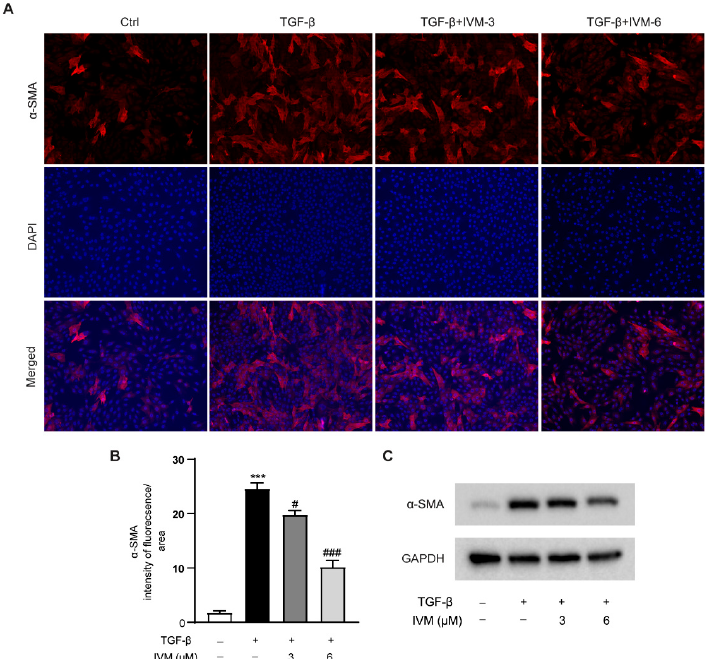
Figure 7. Effects of ivermectin on TGF- β 1-induced HSC activation: ( A ) IHC staining of α -SMA in CFSC cells that received TGF- β 1 stimulation and ivermectin treatment; ( B ) α -SMA intensity of fluorescence; ( C ) the Western blot analysis of α -SMA protein expression in CFSC cells. Data are expressed as means ± SEM ( n = 3). Note: *** p < 0.001 vs. control group, # p < 0.05, ### p < 0.001 vs. TGF- β 1-treated model group.